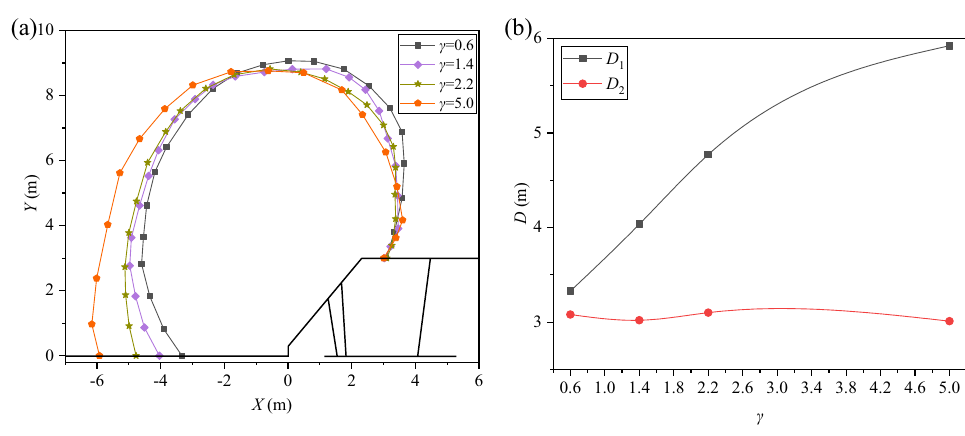
Fig. 22 Variation of the initial drawing body with γ : a Shape of the initial drawing body; b Variation of D